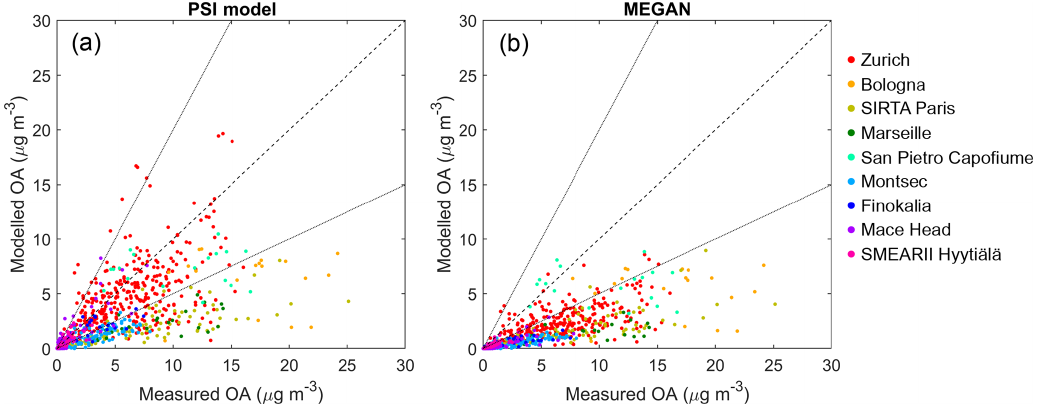
Figure 7. Modelled versus measured daily OA concentrations using BVOC emissions calculated by the PSI model (PSI OA) (a) and MEGAN (MEGAN OA) (b) at nine ACSM/AMS stations. The dashed line represents the 1 : 1 line and dotted lines represent the 2 : 1 and 1 : 2